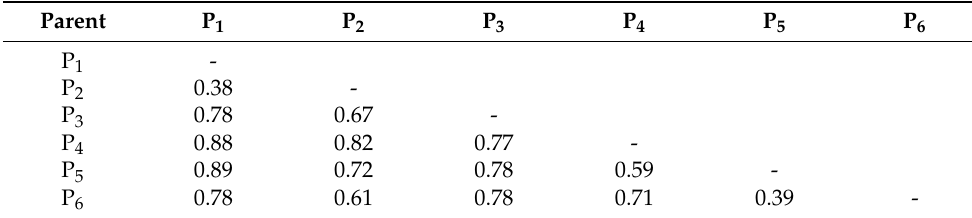
Table 7. Genetic distance among the assessed parental genotypes based on SSR markers.